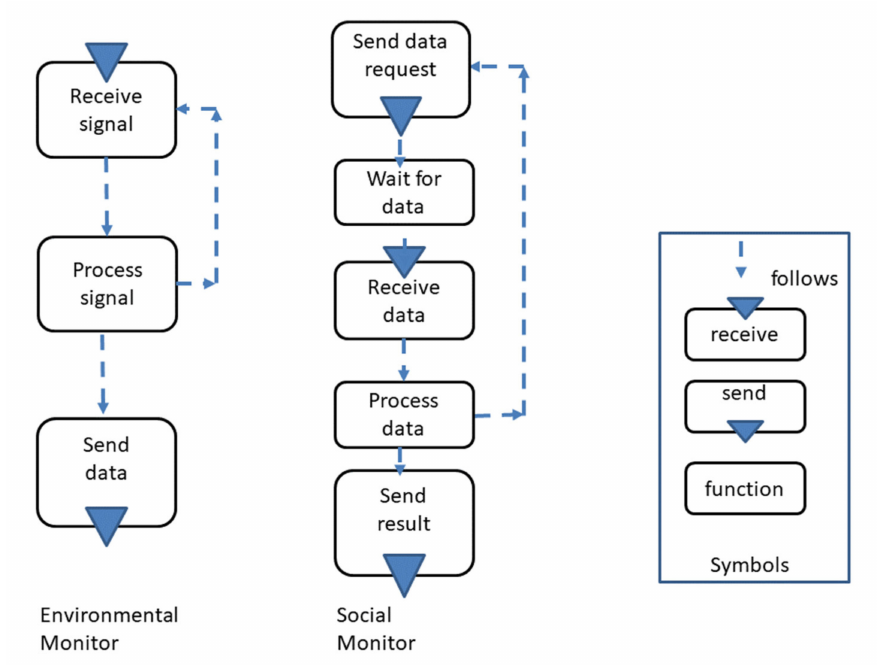
Figure 15. Monitor variants, environmental monitoring as a functional delivery of data, and so- cial